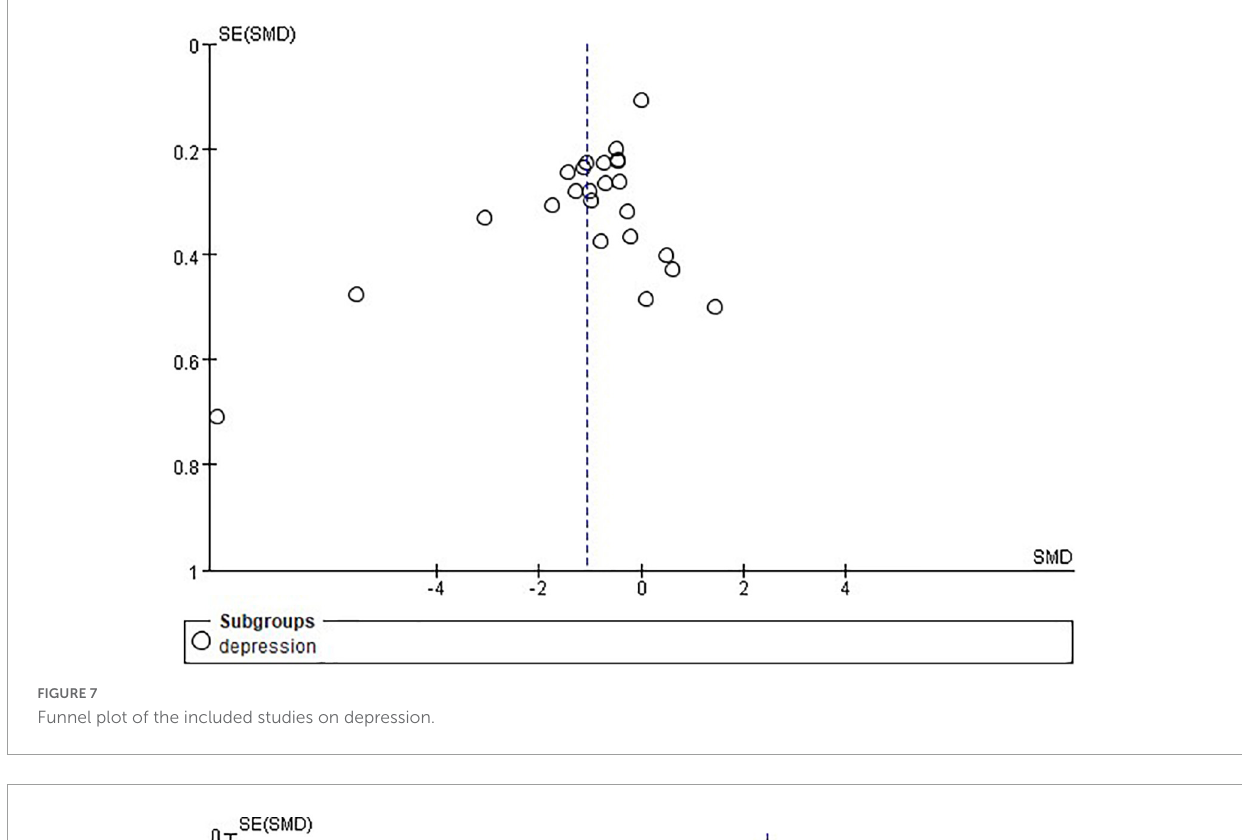
FIGURE7 Funnel plot of the included studies on depression.